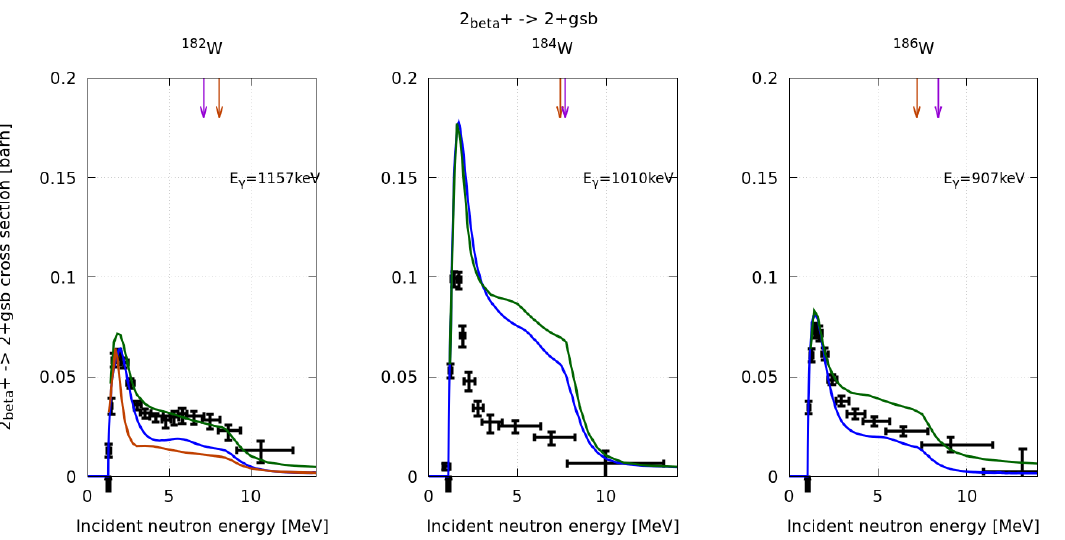
Figure 5. Same as figure 1, for the 2 + dataset.